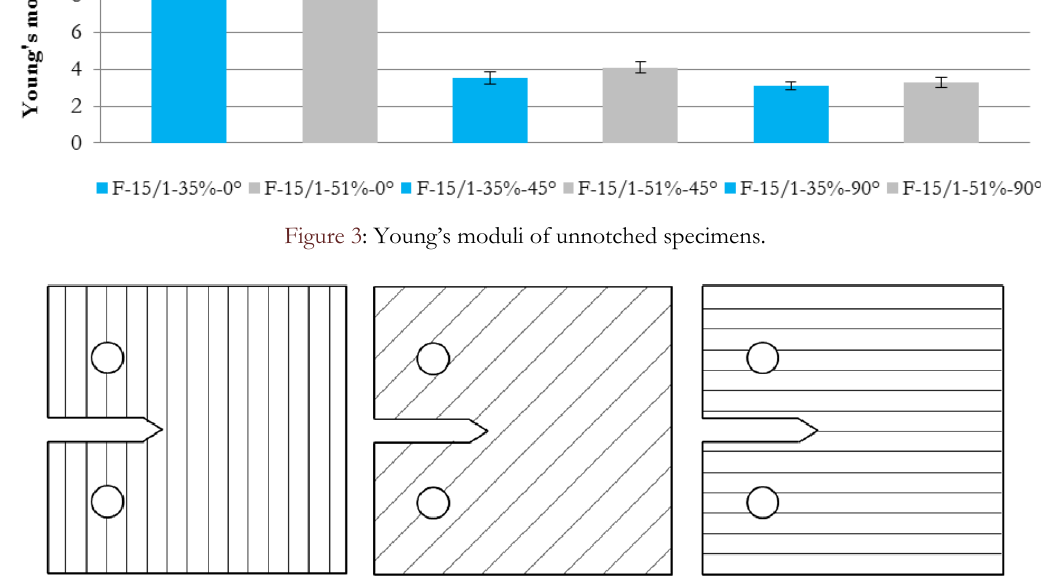
Figure 4: Schematic illustration of compact tension specimens with different fibre directions (0°, 45°,